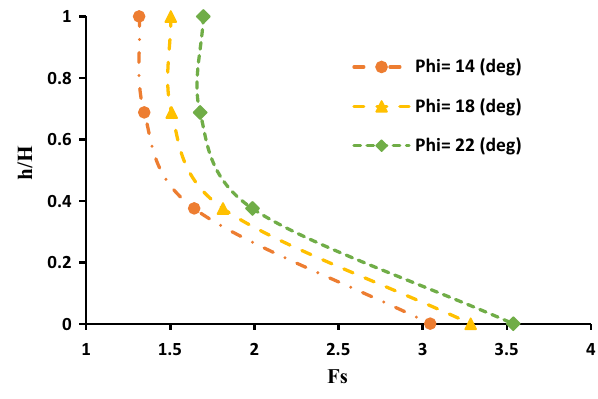
Fig. 12 Changes in factor of safety ( F loss ( h / H ) for the state ( m = 0.125, 𝛽 = 30